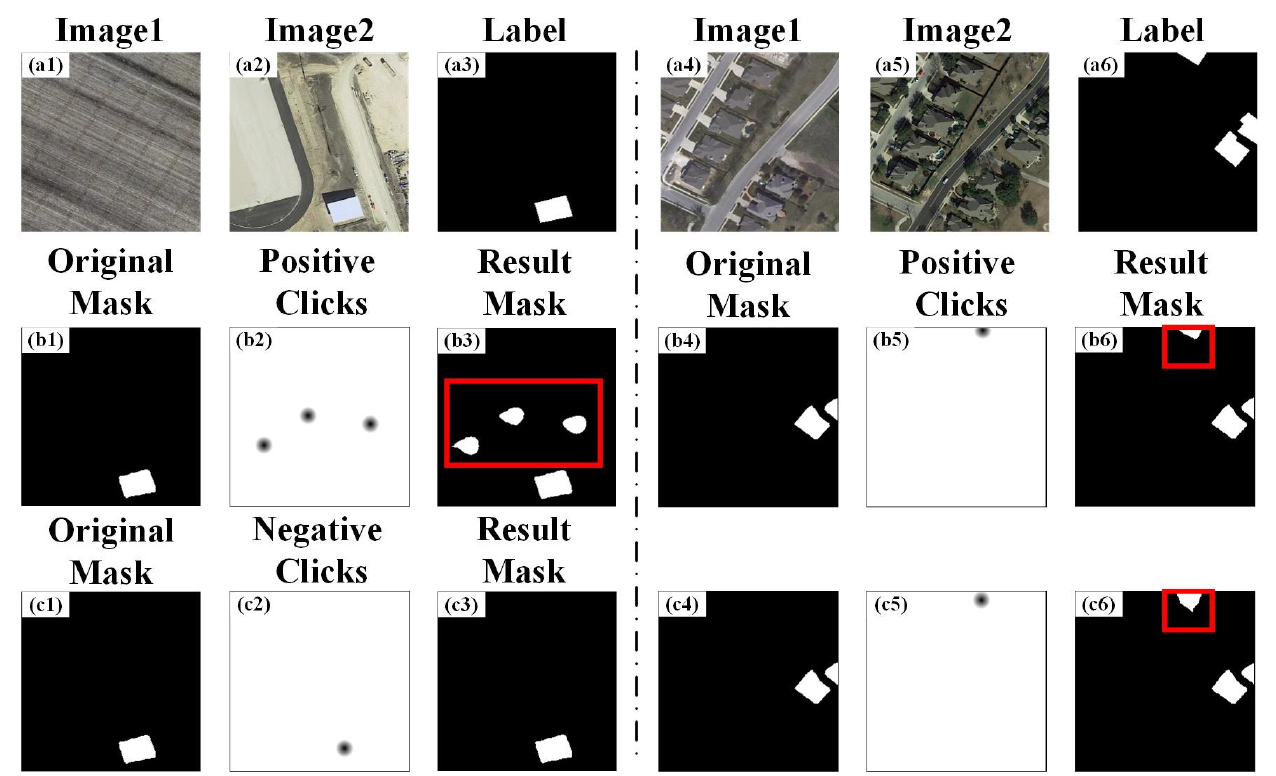
Figure 12. Wrong clicks example. ( a1 )-( a6 ) original samples; ( b1 )-( b3 ) correction results of wrong positive clicks; ( c1 )-( c3 ) correction results of wrong negative clicks; ( b4 )-( b6 ) the accurate correc- tion results ; ( c4 )-( c6 ) the inaccurate correction results. positive clicks; ( c1 – c3 ) correction results of wrong negative clicks; ( b4 – b6 ) the accurate correction results; ( c4 – c6 ) the inaccurate correction